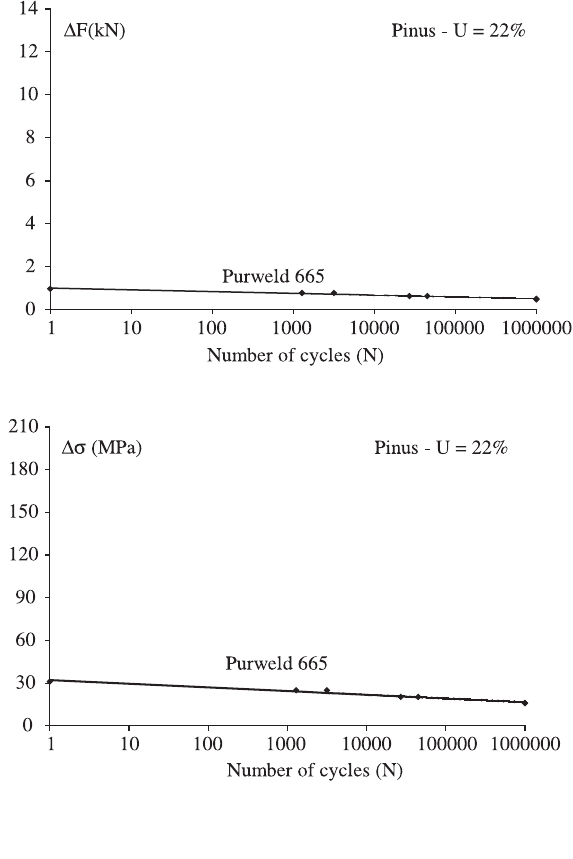
Figure 8. Fatigue performance of the PUR adhesive – Moisture =